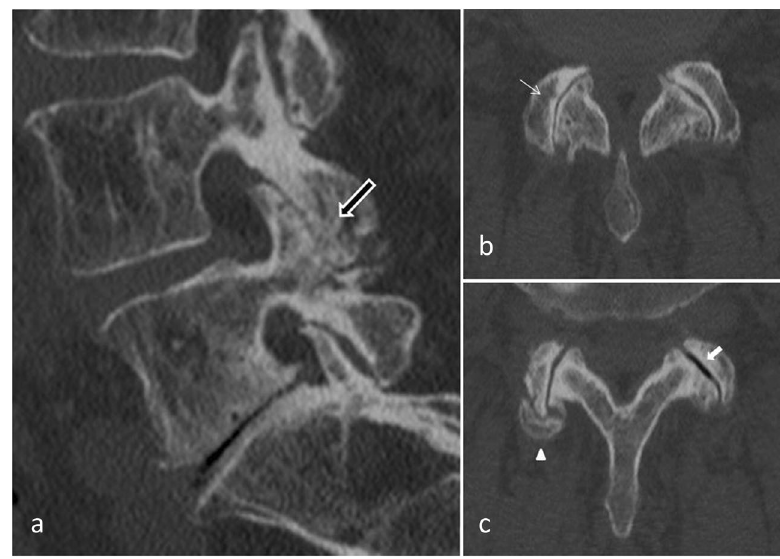
Fig. 2 Degenerative facet joint osteoarthritis (FJOA): Sagittal ( a ) and axial ( b , c ) CT views. Hypertrophy of the posterior articular process (black arrow). Joint space narrowing (thin white arrow). Joint capsule calcification (arrow head) and vacuum phenomenon (white